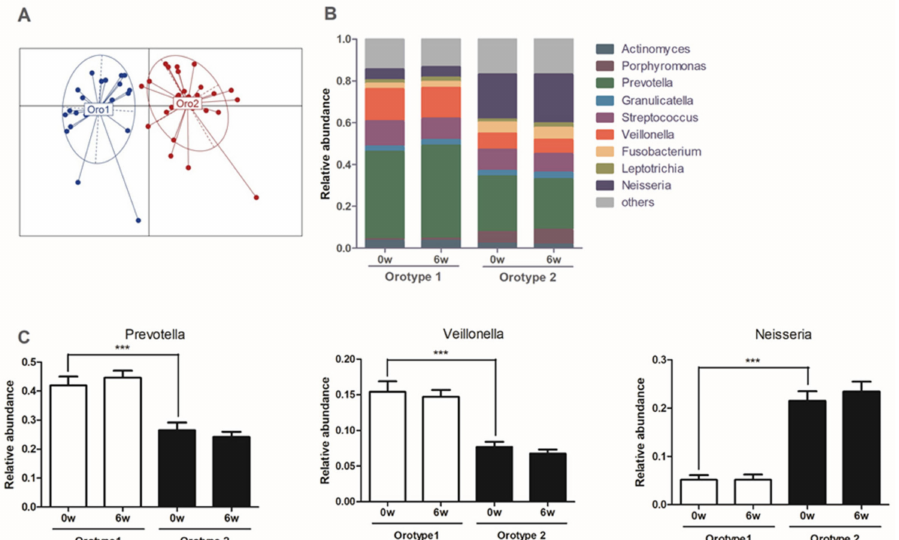
Figure 8. Identification of oral microbiota types. ( A ) Oral microbial communities in orotypes. ( B ) Relative abundances at the genus level for each orotype. ( C ) Relative abundances of the three bacterial taxa principally responsible for the dichotomization of orotypes. Data are presented as means ± standard deviations (*** p <